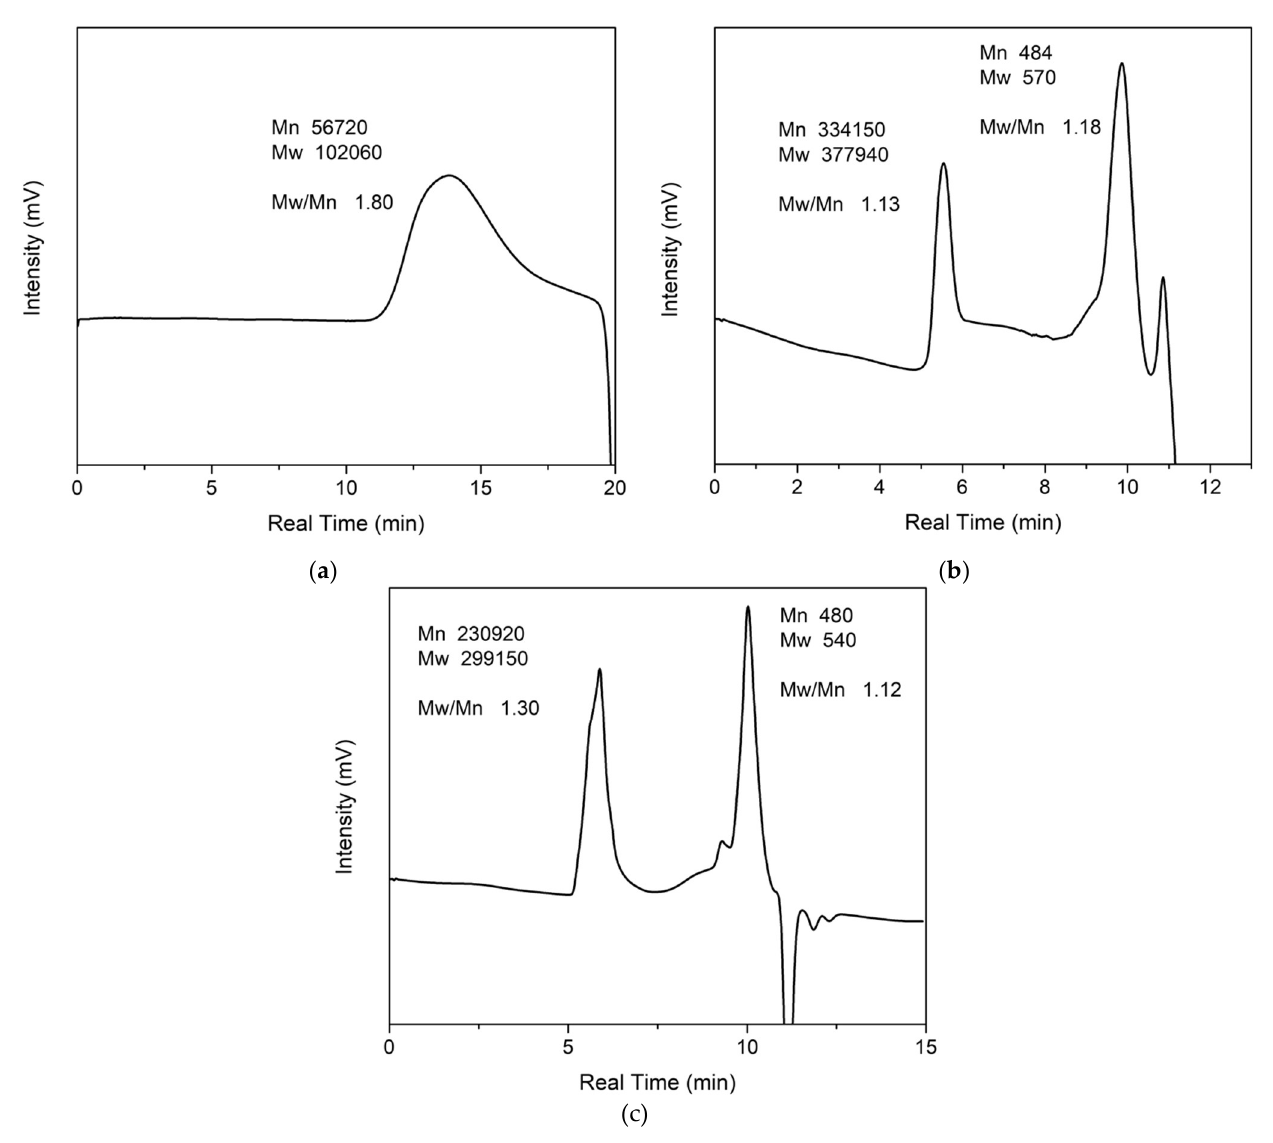
Figure 8. GPC of ( a ) PMMA; ( b ) double concentration ZnAl 2 O 4 :Mn/GO/PMMA; ( c ) ZnAl 2 O 4 : Mn/GO/PMMA.